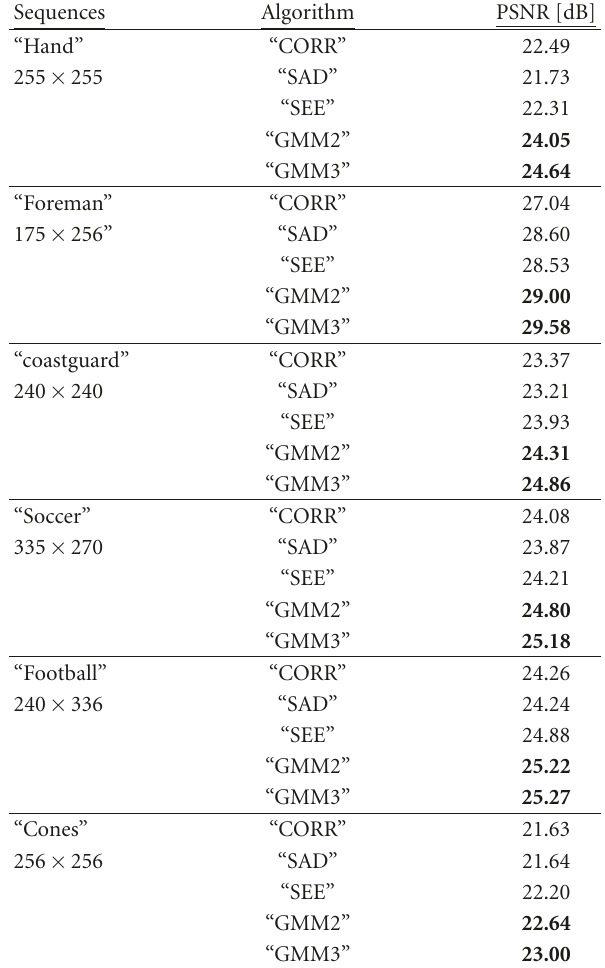
Table 4: Average PSNR Values for test